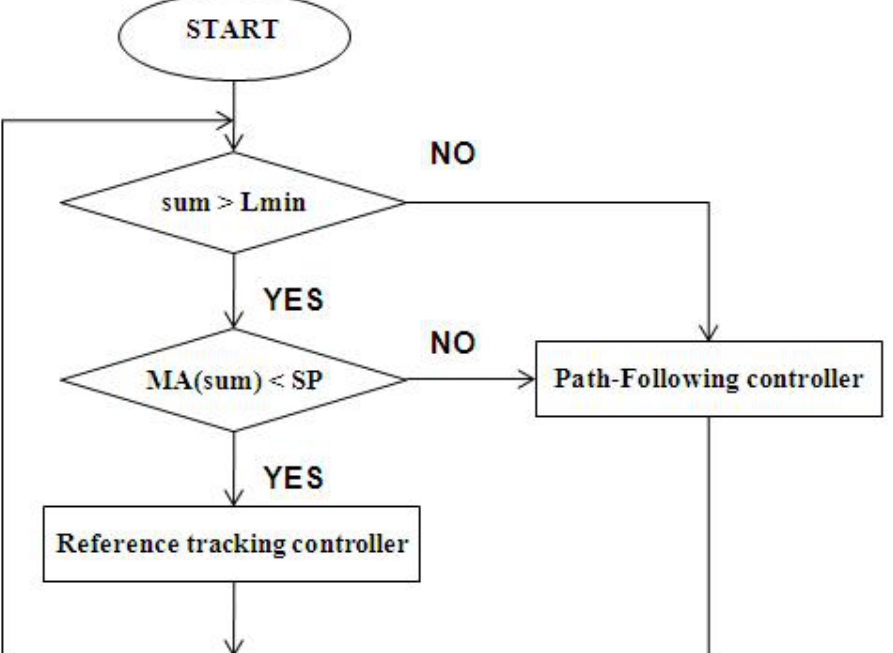
Figure 6. Flow diagram of Logic-based Supervisor(L BS).